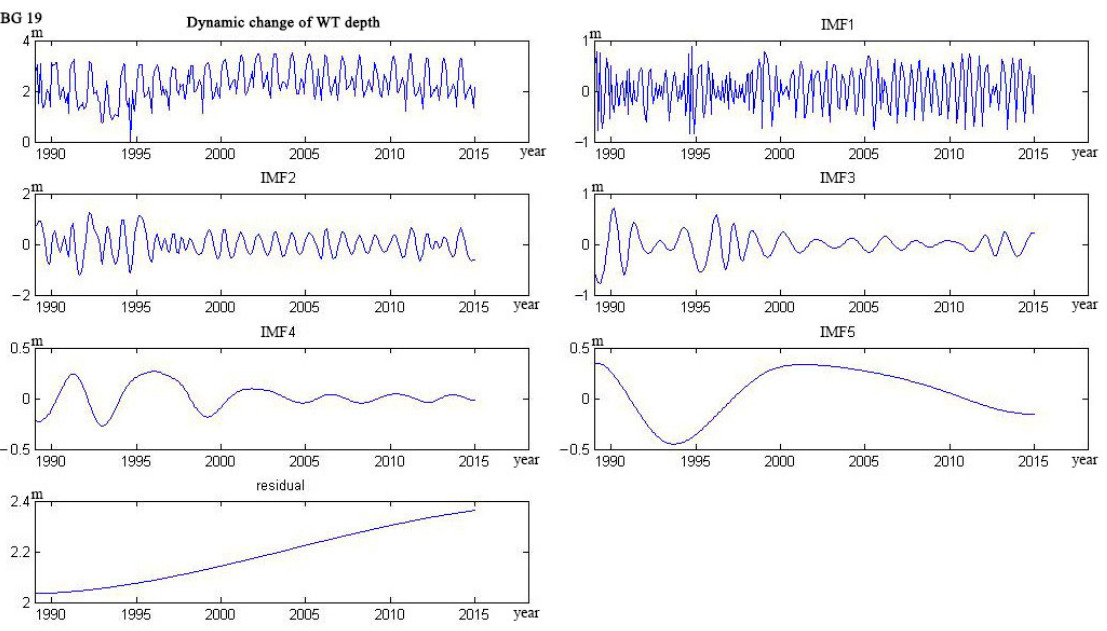
Figure A14. Decomposition of groundwater time series data of well BG19.